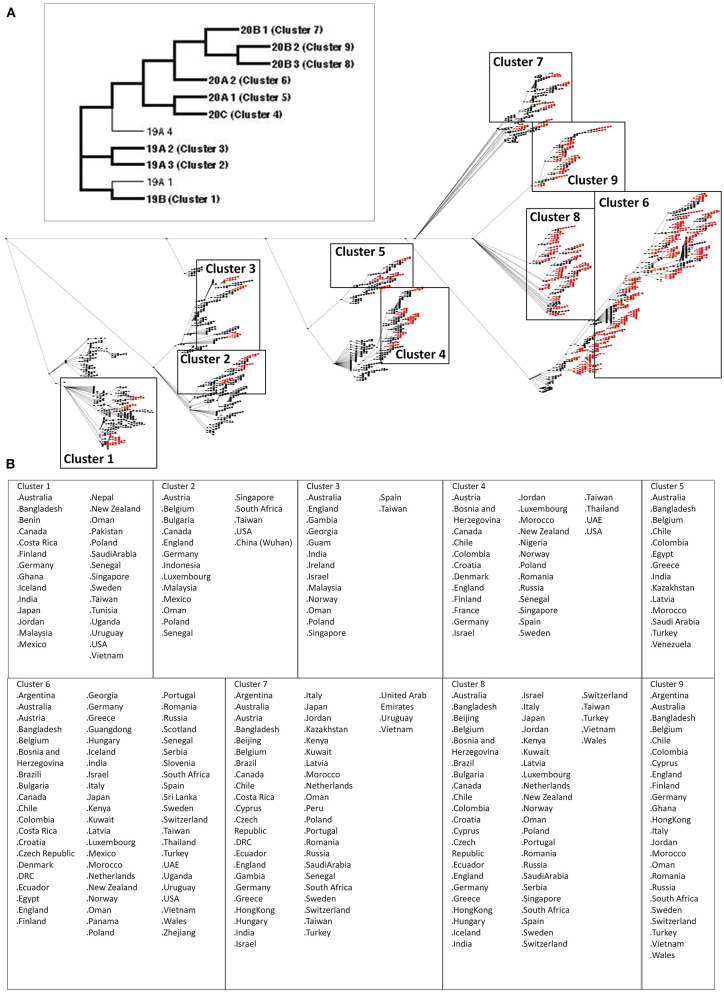
Nine significant node clusters within the COVID-19 genomic epidemiology network designed between December 2019 and July 2020. (A) COVID-19 genomic epidemiology network. (Upper panel) Simplified network, with the genomic clades and node clusters labeled. (Lower panel) Actual network, with the significant nodes (red) as determined by centrality analyses are shown. Nodes (dots) and edges (lines) are indicated. Node clusters are boxed and labeled. (B) List of countries identified by the significant nodes and classified according to node cluster.